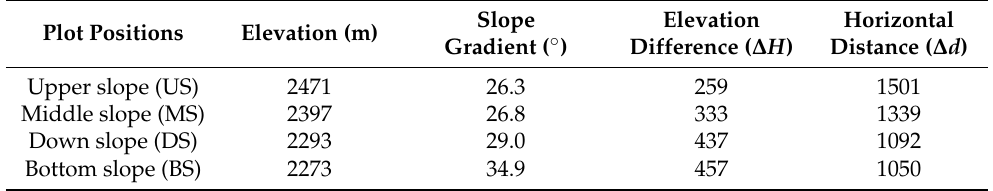
Table 2. The stand characteristics of Larix principis - ruprechtii plantation plots on the study slope. Stand Density Mean Diameter at Mean Tree Mean Canopy Plot Positions (Trees ha − 1 ) Breast Height (cm) Height (m) Diameter (m) Upper slope (US) 856 21.83 19.4 4.5 Middle slope (MS) 844 22.29 20.0 3.7 Down slope (DS) 742 20.63 19.2 4.5 Bottom slope (BS) 711 21.40 19.5